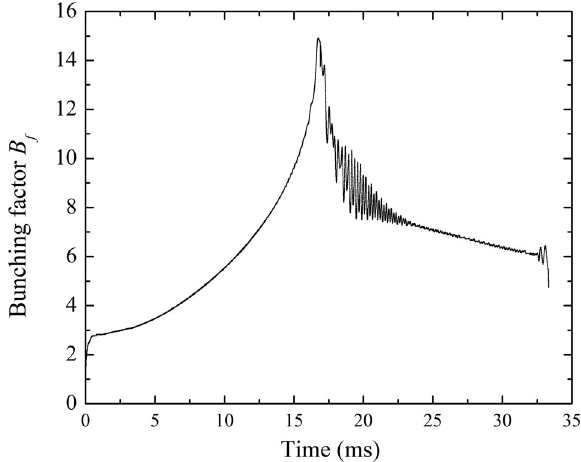
FIG. 11. Booster bunching factor over the accelerator ramp (ratio of the peak to average proton beam